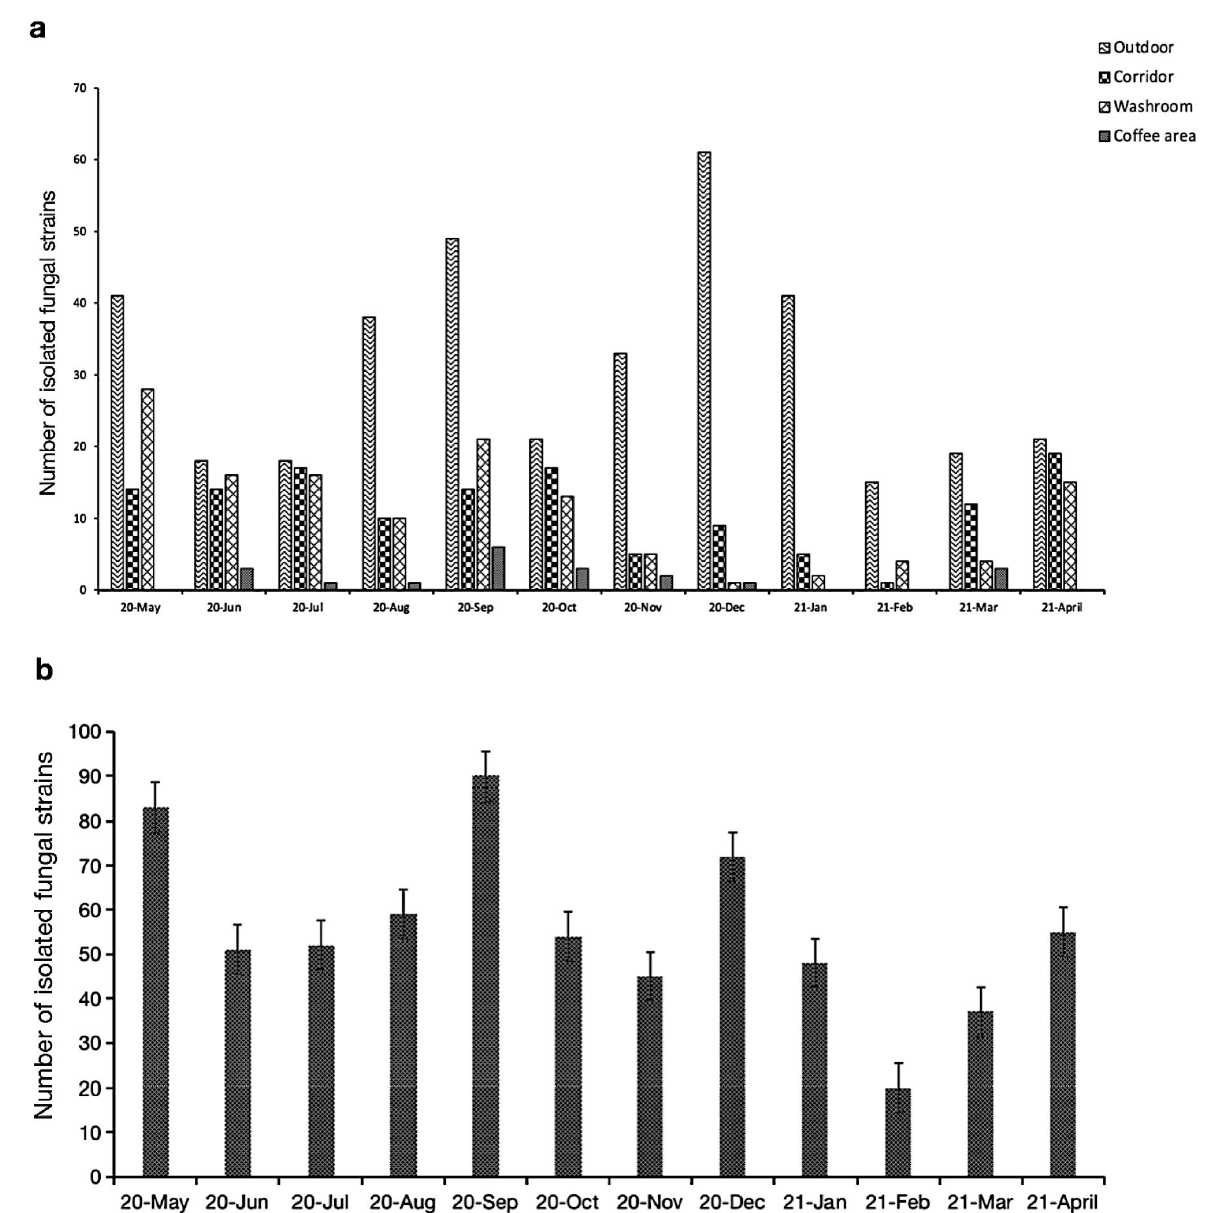
Figure 3. Total strains isolated during the one-year sampling from each location ( a ) and month ( b